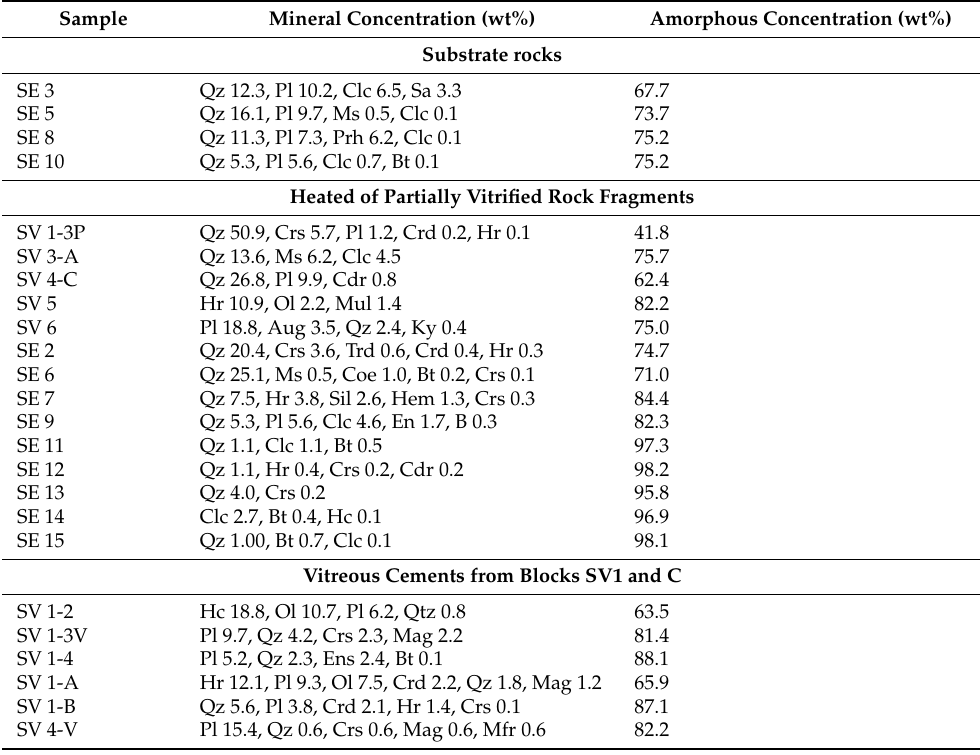
Table 2. Mineralogical composition of analyzed samples calculated via Rietveld method fitting the complete experimental X-ray powder diffraction (XRPD) patterns with calculated profiles and background. Crystalline and amorphous concentrations in wt%, as determined by Rietveld analysis. Mineral abbreviations from Whitney and Evans [5]. Qz = quartz, Pl = plagioclase, Crs = cristobalite, Mul = mullite, Hc = hercinite; Trd = tridimite; Sa = sanidine; Ms = muscovite; Coe = coesite; Hem = hematite; Sil = sillimanite; Bt = biotite; En = enstatite; Prh = prehnite; Crd = cordierite; Clc = clinochlore; Ol = olivine; Mag = magnetite; Mfr =: magnesioferrite; Aug = augite; Ky =